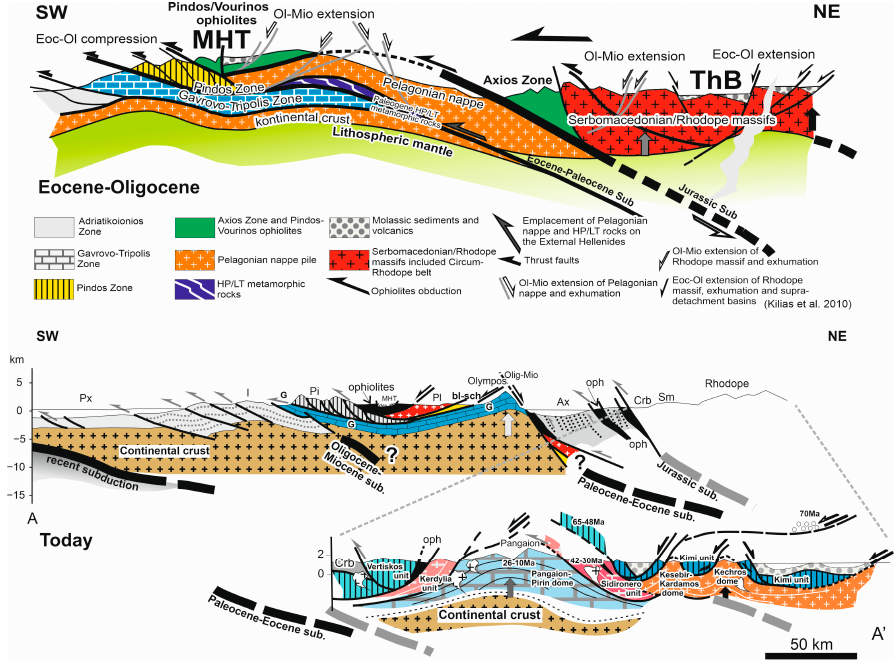
Figure 3. Geological cross-sections through the Hellenides during the Eocene-Oligocene and today (location in Figure 2). The geotectonic position of the MHT and THB molassic basins is shown [7,28]. After Kilias et al.